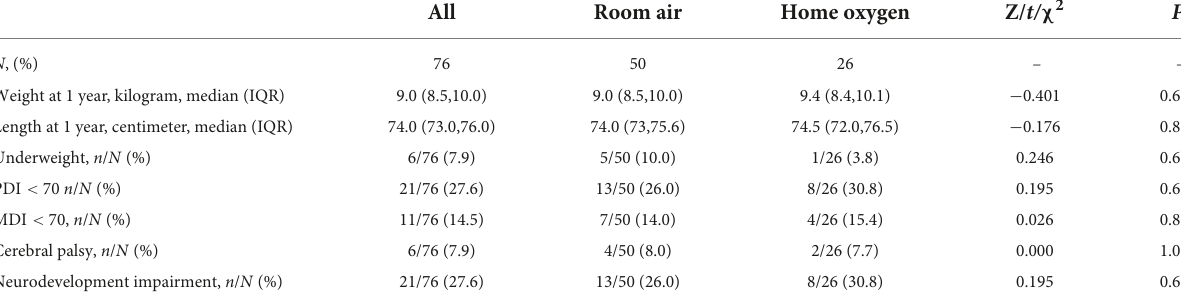
TABLE 3 Long-term outcomes between the two groups. All Room air Home oxygen Z/ t/ χ